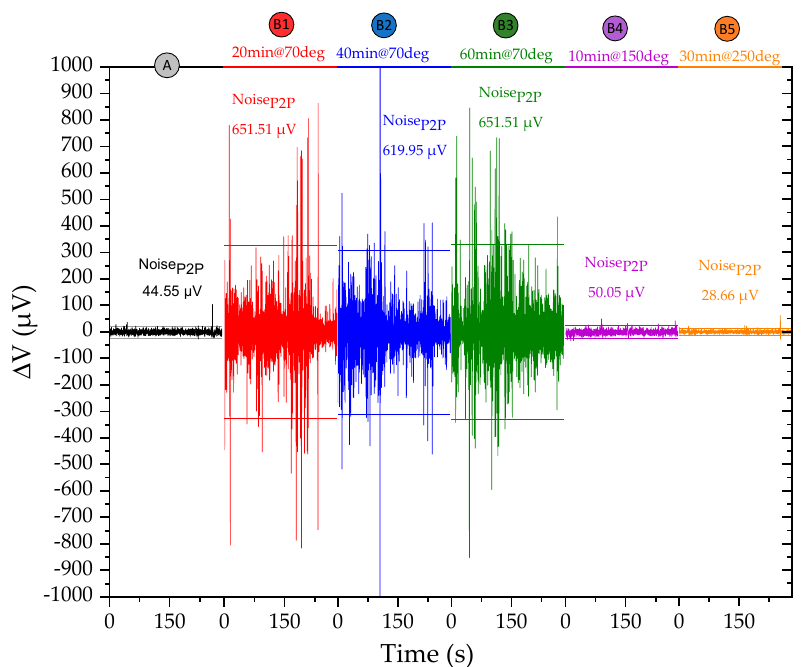
Figure 9. Comparison of different curing procedures. We show the voltage variation ( μ V) of the sensor used in L1 during a 300 s measurement at H = 0 T using a Keithley 220 as a current source, Keithley 182 voltmeter, and micrometric probes to make contact with: the contact pads of the Si chip ( ), the FPC with the Si chip bonded with the epoxy cured at 70 °C for 20 min ( ), 40 min ( ) and 60 min ( ), cured at 150 °C for 10 min ( ) and 250 °C for 30 min ( ).